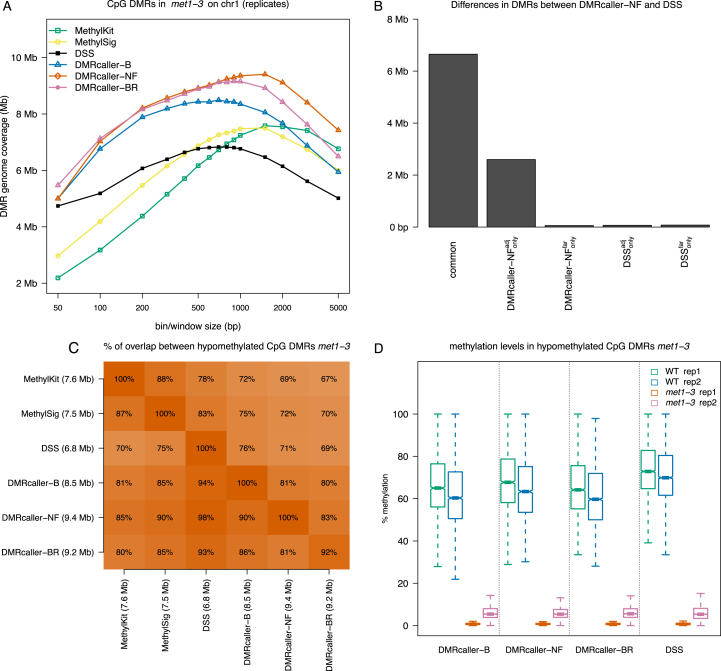
Computing DMRs with biological replicates. We computed DMRs using: (i) methylKit, (ii) methylSig, (iii) DSS, (iv) DMRcaller Bins (DMRcaller-B), ($v$) DMRcaller Noise filter (DMRcaller-NF) and (vi) DMRcaller with bins and beta regression (DMRcaller-BR). DMRs between WT plants and met1-3 plants were computed on chromosome 1. (A) Genome coverage. (B) We considered the DMRs identified by DMRcaller-NF method and the DMRs identified by DSS and split the DMRs into common DMRs, DMRcaller-NF specific and DSS specific. Furthermore, the DMRs specific to each method were split based on their relative location into: adjacent to common ones (\documentclass[12pt]{minimal}
\usepackage{amsmath}
\usepackage{wasysym}
\usepackage{amsfonts}
\usepackage{amssymb}
\usepackage{amsbsy}
\usepackage{upgreek}
\usepackage{mathrsfs}
\setlength{\oddsidemargin}{-69pt}
\begin{document}
}{}$\textrm{DMRcaller-NF}^{\textrm{adj}}_{\textrm{only}}$\end{document} and \documentclass[12pt]{minimal}
\usepackage{amsmath}
\usepackage{wasysym}
\usepackage{amsfonts}
\usepackage{amssymb}
\usepackage{amsbsy}
\usepackage{upgreek}
\usepackage{mathrsfs}
\setlength{\oddsidemargin}{-69pt}
\begin{document}
}{}$\textrm{DSS}^{\textrm{adj}}_{\textrm{only}}$\end{document}) or far from common ones (\documentclass[12pt]{minimal}
\usepackage{amsmath}
\usepackage{wasysym}
\usepackage{amsfonts}
\usepackage{amssymb}
\usepackage{amsbsy}
\usepackage{upgreek}
\usepackage{mathrsfs}
\setlength{\oddsidemargin}{-69pt}
\begin{document}
}{}$\textrm{DMRcaller-NF}^{\textrm{far}}_{\textrm{only}}$\end{document} and \documentclass[12pt]{minimal}
\usepackage{amsmath}
\usepackage{wasysym}
\usepackage{amsfonts}
\usepackage{amssymb}
\usepackage{amsbsy}
\usepackage{upgreek}
\usepackage{mathrsfs}
\setlength{\oddsidemargin}{-69pt}
\begin{document}
}{}$\textrm{DSS}^{\textrm{far}}_{\textrm{only}}$\end{document}). (C) Overlap of DMRs between different methods. (D) Methylation level in DMRs for each sample.